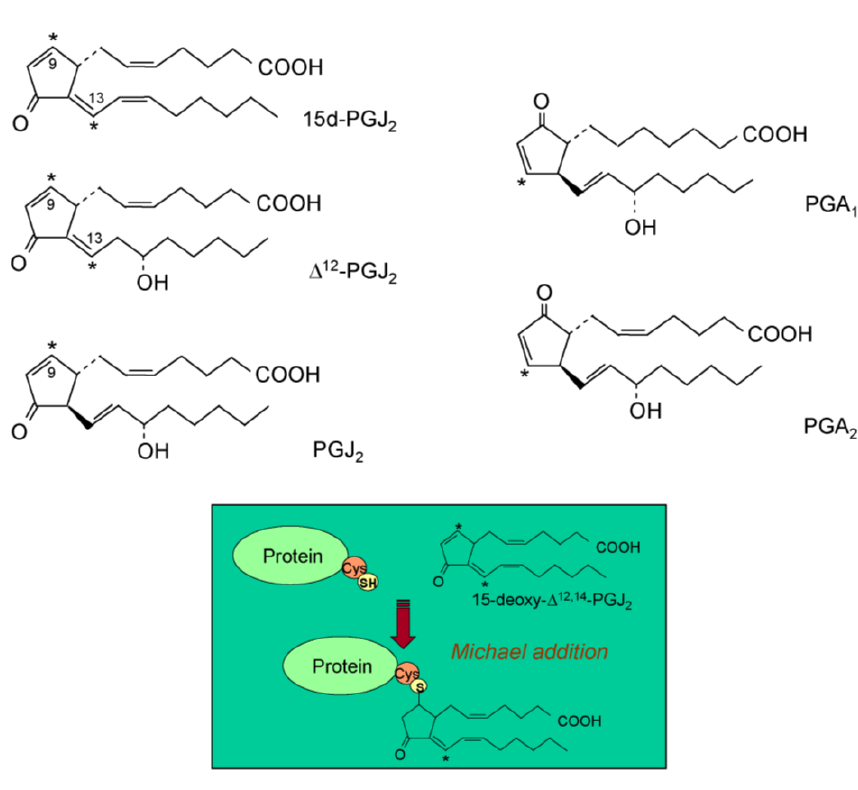
FIGURE 2 . Structures of several cyPG and scheme of the Michael addition. The structure of several cyPG of the J or the A series is depicted. Note the variability in the configuration and presence of substituents in the lateral chains. Also, the number of electrophilic carbons, marked by asterisks, is different. The lower scheme depicts the adduct formed by nucleophilic attack on the carbon in the  - position of the